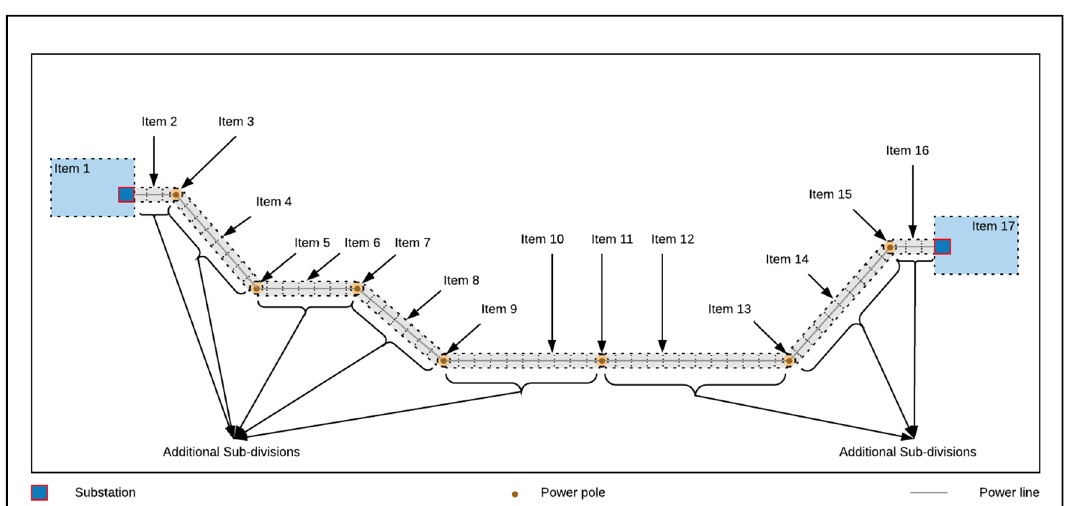
Figure 8. Section subdivision of a schematic power grid. The items of interest consist here of the substations, the power poles, and the power line subsections (Aerial 2D view).